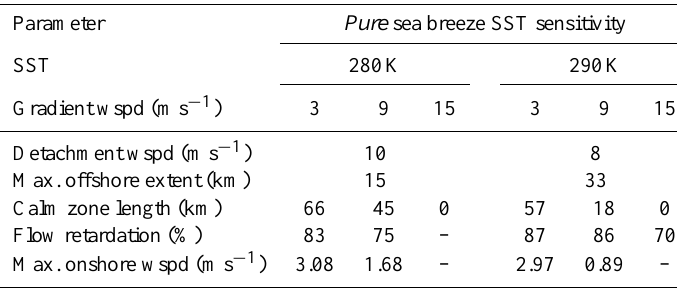
Table 7. Dual-coast pure sea breeze response to varying SST. In both cases the YSU PBL scheme was selected and the simulations run with 2ms − 1 offshore gradient winds. Supporting figures can be found in the Supplement (Fig.